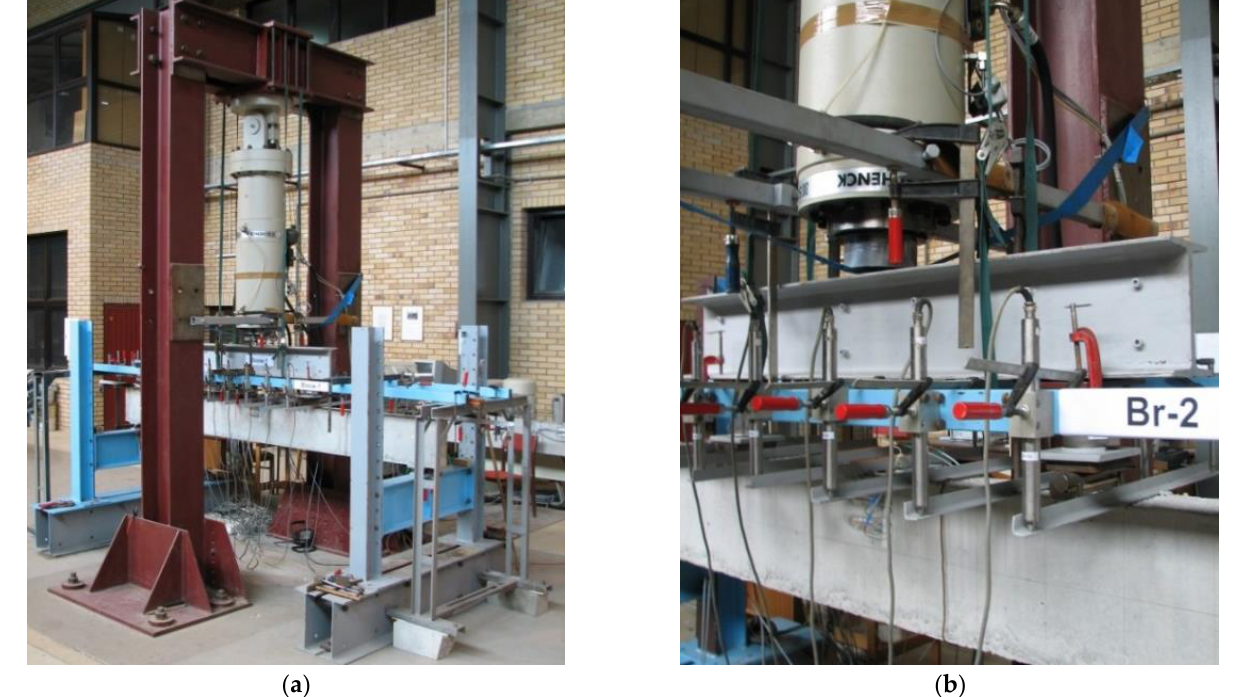
Figure 2. Research stand with beam during the tests: ( a ) view on the whole beam and actuator; and ( b ) view of load bearing traverse and on the deflection measurement points.